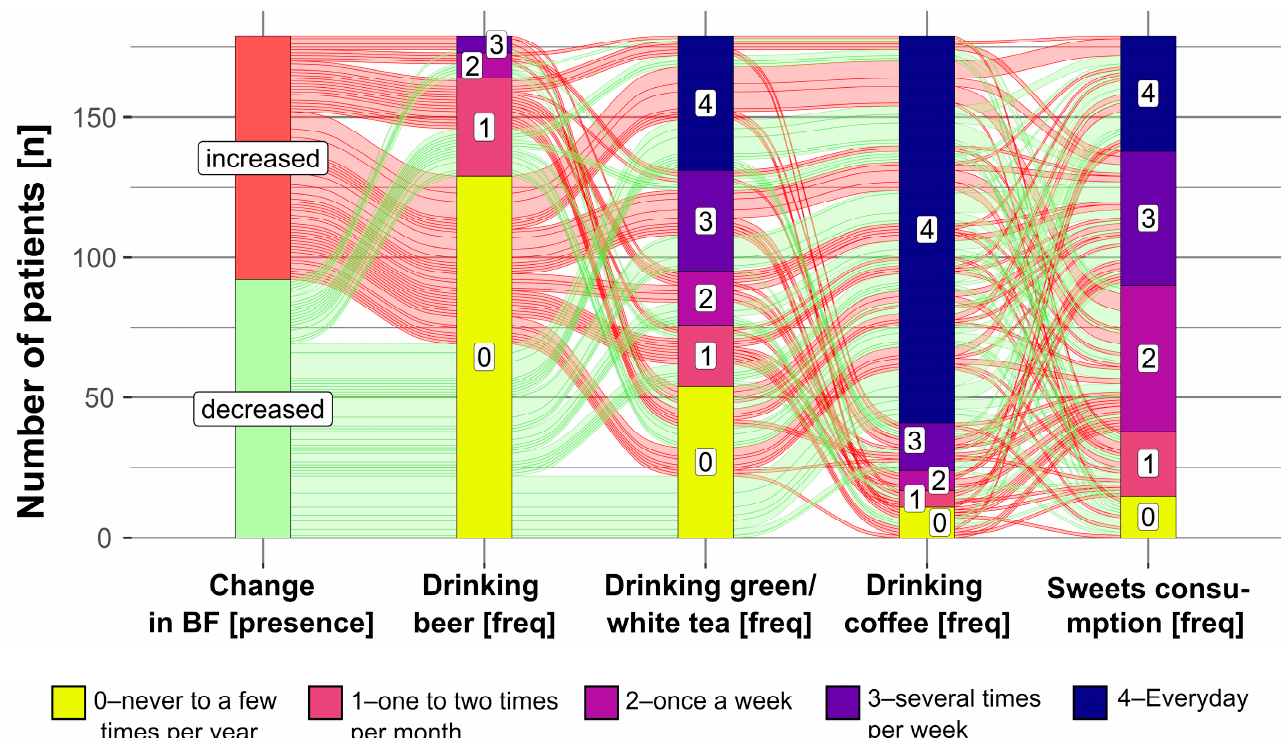
Figure 2. Alluvial diagram showing the relationship between the presence of body fat (BF) change with the frequency of selected food products consumption.